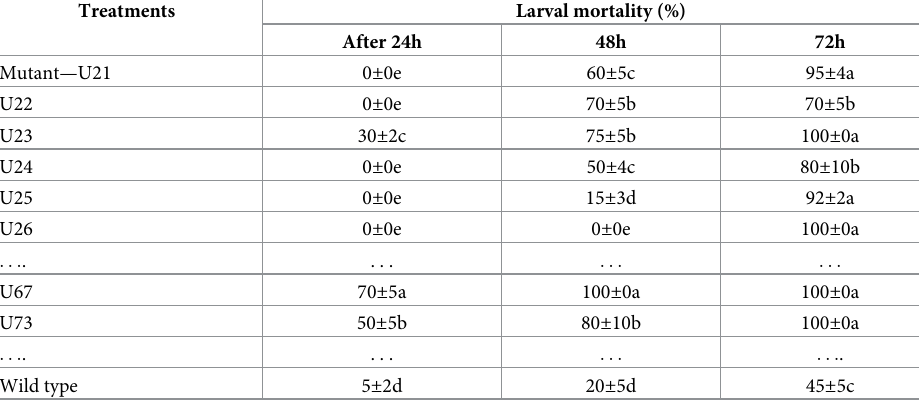
Wild type 5 ± 2d 45 ± 5c To estimate the larvicidal activity, Chinese cabbage leaf disks (diameter 3 cm) were dipped for 30 seconds in five-fold diluted (x1/5) each mutant and wild broth filtrate solutions. Once the leaf disks surface-dried they were inoculated with P . xylostella 2 nd instars (10 larvae/disk). Values are the mean of three replication and different letters in each column indicate significant differences in the Fisher’s LSD test (P <